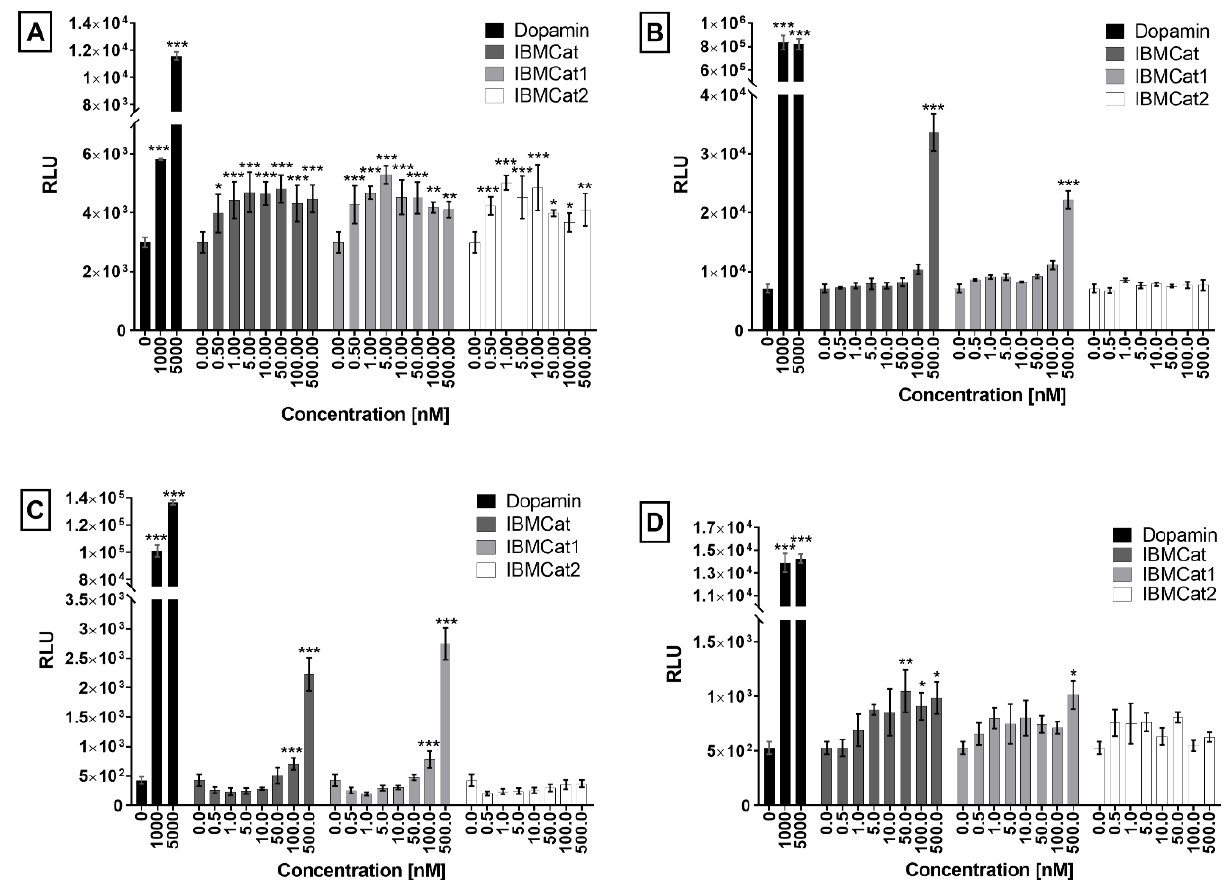
Figure 8. β -Arrestin 2 recruitment PRESTO-Tango assay: activation of the dopamine receptors. The plots represent the luminescence level of oxyluciferin (relative light unit, RLU) arisen in HTLA cells transfected with pDNA encoding the dopamine receptors and treated with 4-isobutylmethcathinone (IBMCat) and its enantiomers IBMCat1 an IBMCat2 at 0–500 nM concentration. As a control, a ligand of dopamine receptors (DAR), dopamine (1 and 5 µ M concentration), was used. ( A ) DAR1, ( B ) DAR2, ( C ) DAR3, and ( D ) DAR4. The error bar represents the standard deviation from four replicates. The data were processed and evaluated by GraphPad Prism Software using one-way ANOVA: * p < 0.05; ** p < 0.01; *** p < 0.001.